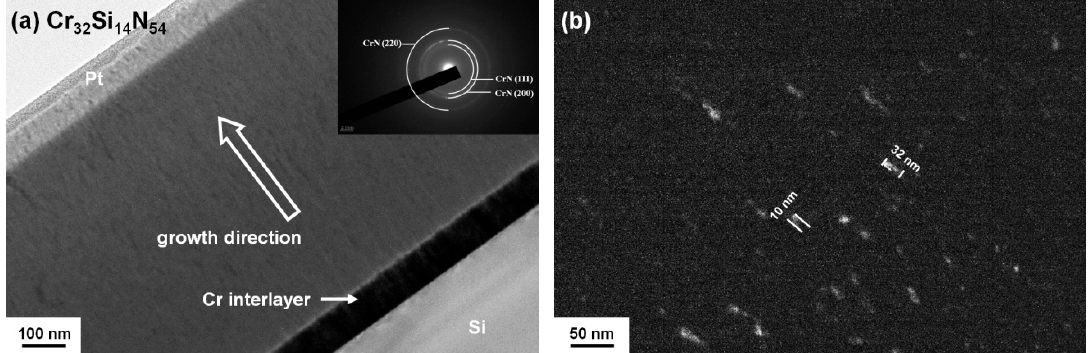
Figure 3. ( a ) Cross-sectional transmission electron microscope (TEM) image and selected-area diffraction pattern (SADP; inset) of the Cr 43 Si 5 N 52 coating; ( b ) the dark field image correlated with the diffraction spot of CrN (200) in the SADP.